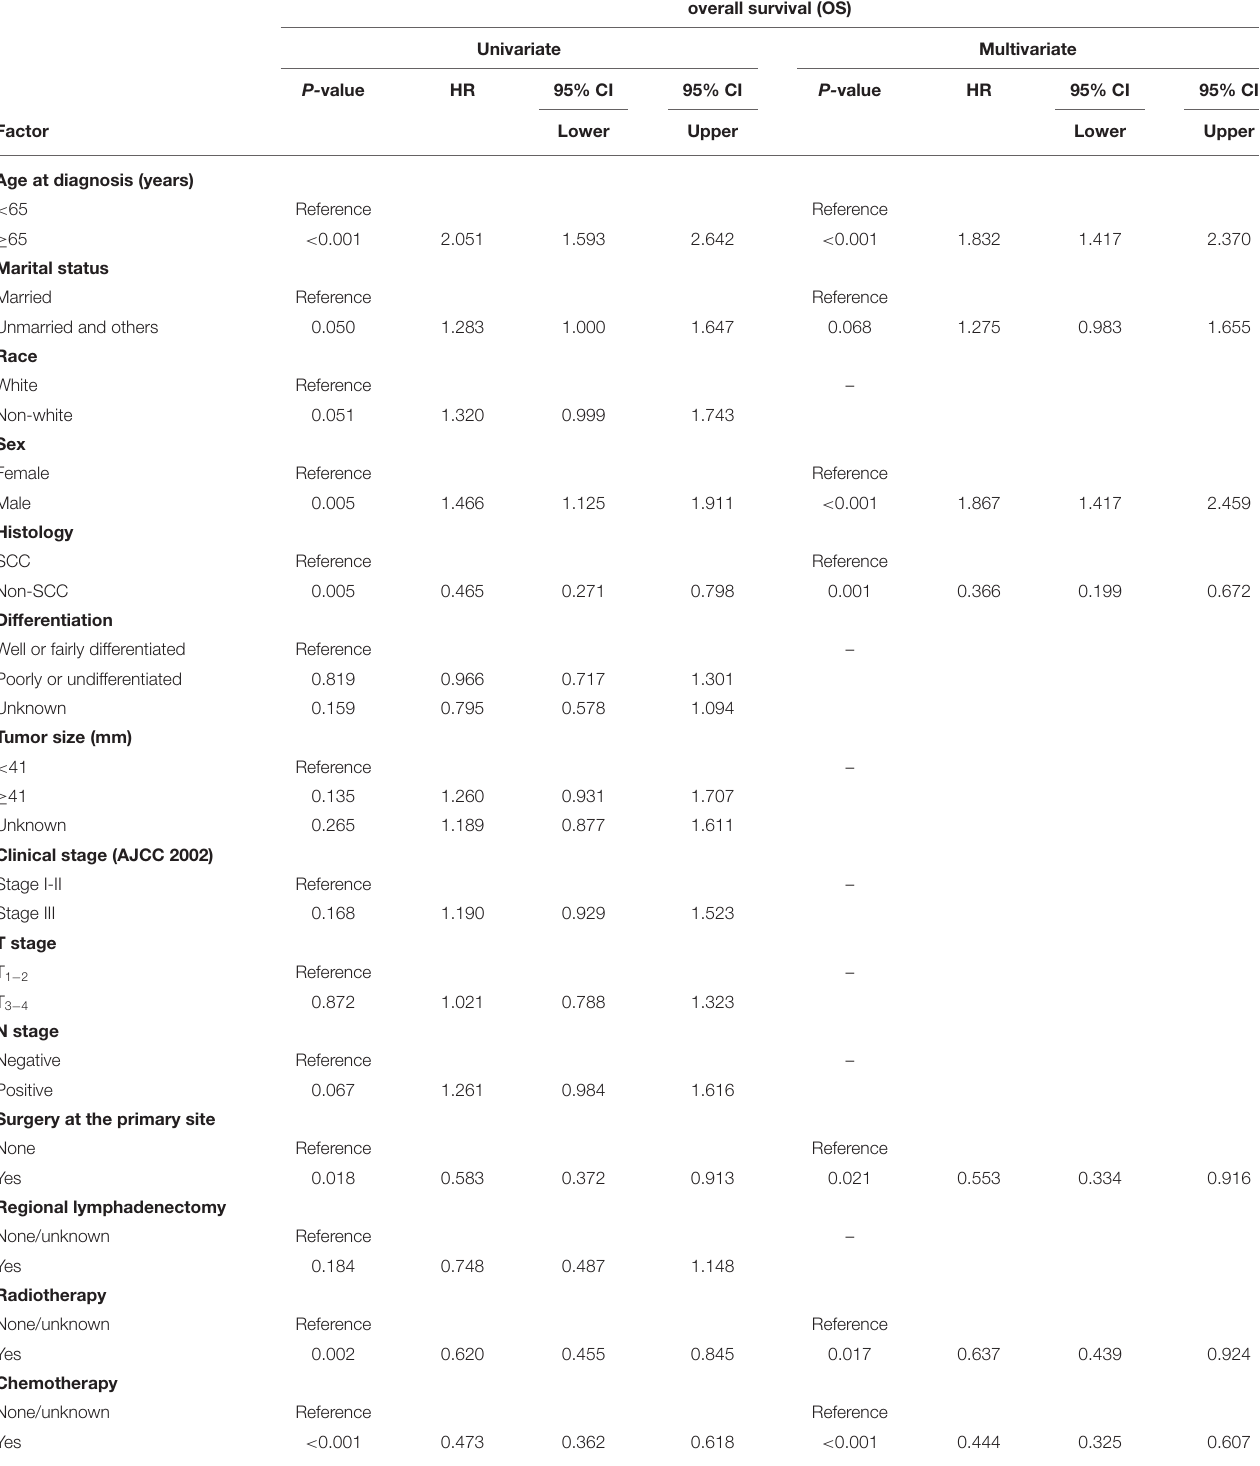
TABLE 2 | Univariate and multivariate analyses of overall survival